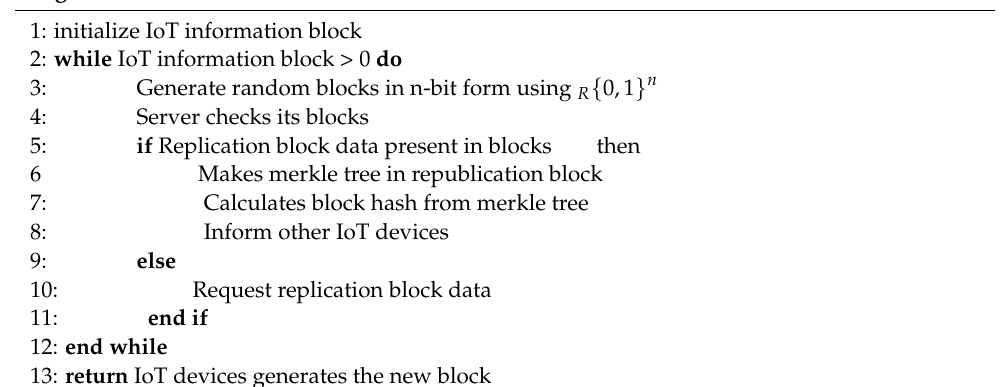
Algorithm 2. IoT Information Block Hash